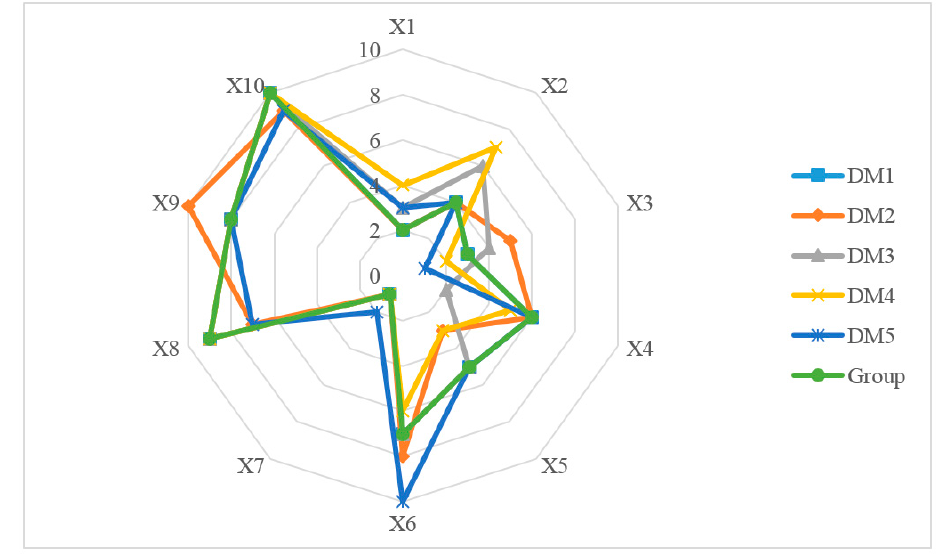
Figure 8. The individual ranking and group ranking for 10 mobile medical APPs based on TOPSIS-EW.